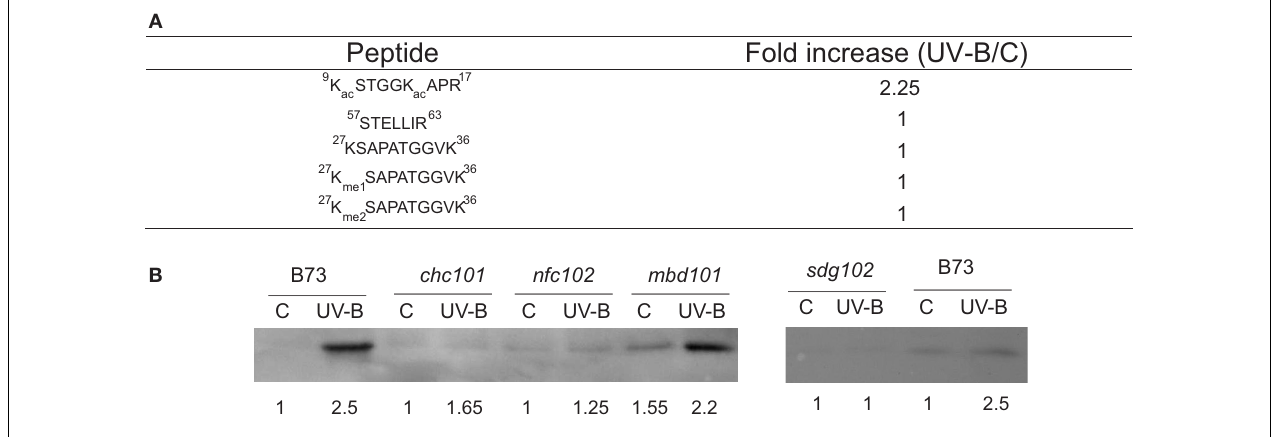
or methylated peptides are not changed by the treatment. (B) Western blot analysis of histone extracts from maize plants revealed using antibodies against acetylated H3 in the N-terminal domain. Quantification of the bands determined by densitometrical analysis of the western blots is shown below each band. Data adapted from Casati et al. (2008) and Campi et al.